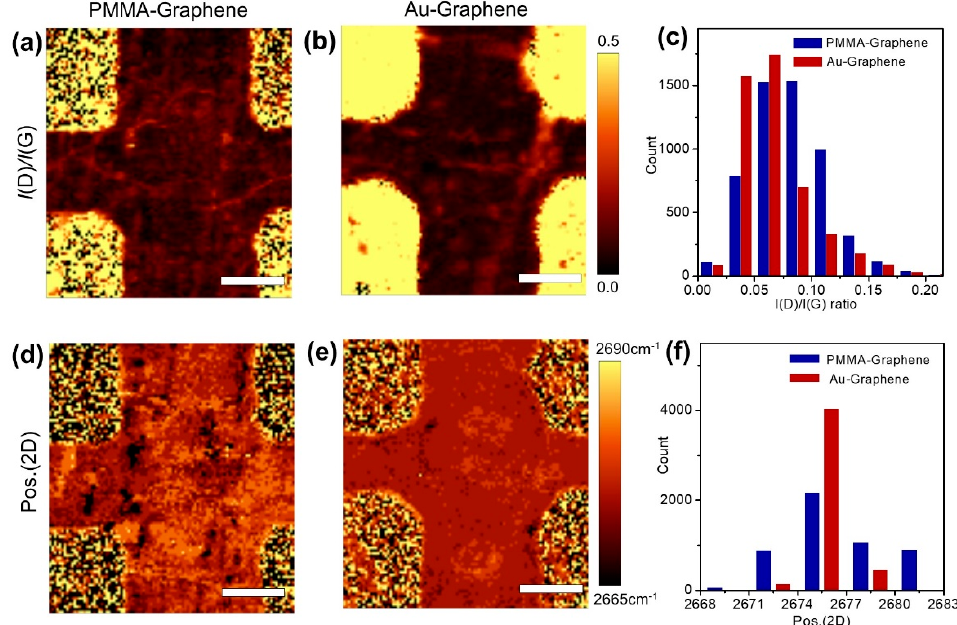
Figure 4. The I (D)/ I (G) Raman mapped image of ( a ) graphene transferred using PMMA and ( b ) graphene transferred using Au film. ( c ) The I (D)/ I (G) ratio distribution graph. The 2D Raman mapped image of ( d ) graphene transferred using PMMA and ( e ) graphene transferred using Au. ( f ) The 2D position distribution graph. Scale bars, 5 μ m.